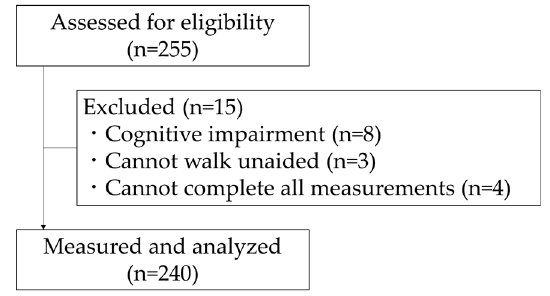
Figure 1. Flowchart of participation in the present study.